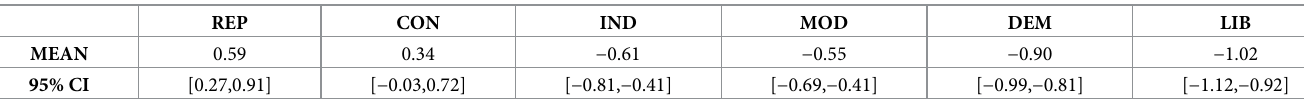
Table 3. Trump approval score A P broken down by party affiliation and political